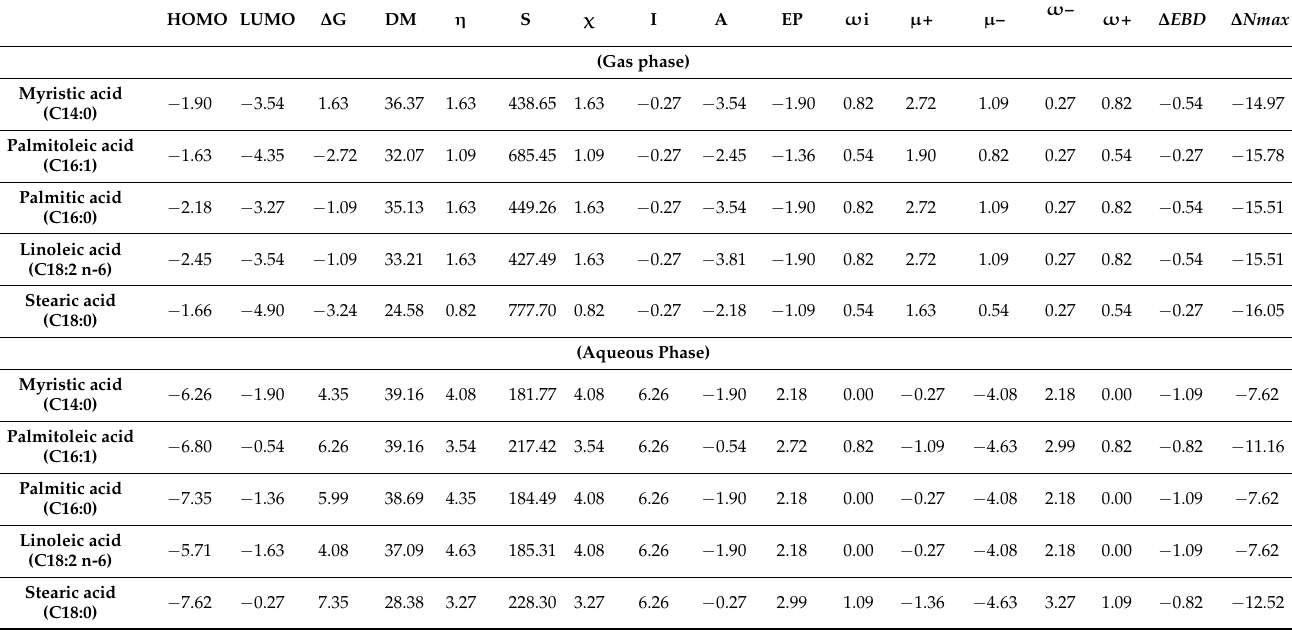
Table 7. Calculated reactivity parameters in electron volts except dipole moment in debye for AO and HERA at